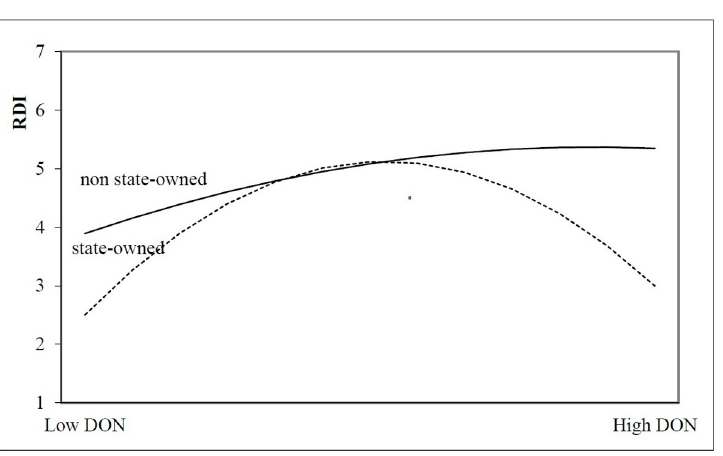
Fig 5. The moderating effect of state-ownership on the relationship between altruistic motivation-oriented charitable donation and innovation investment.